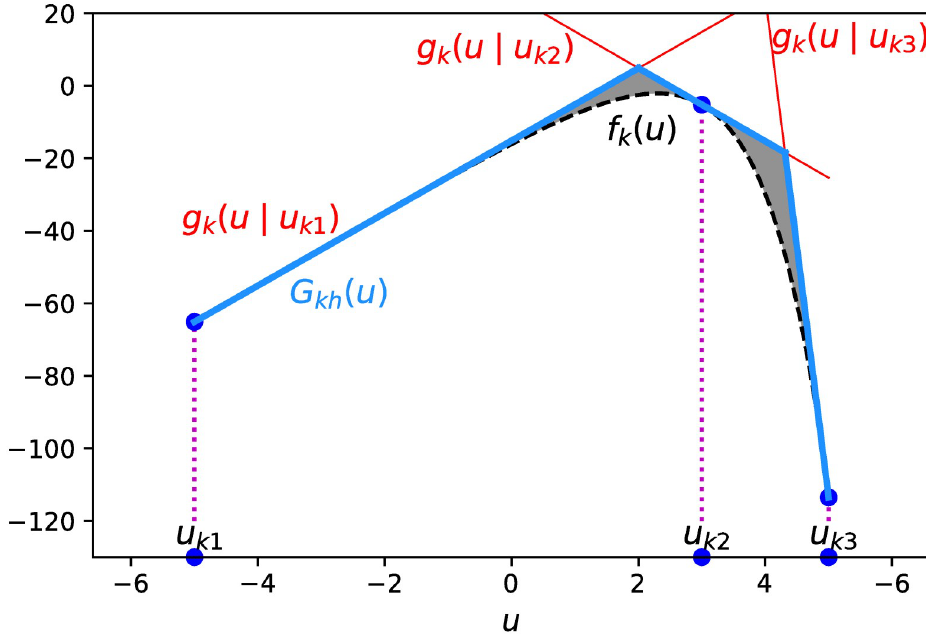
Fig 2. Piecewise-linear approximation of f